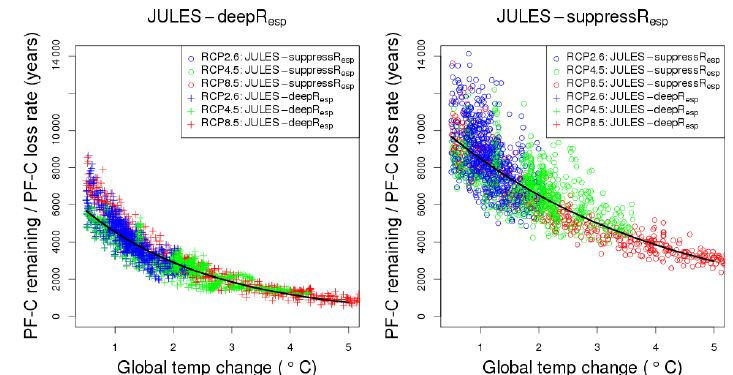
Figure 11. The permafrost carbon remaining in any given year divided by the loss of permafrost carbon in that year (FCRt) as a function of global mean temperature change ( (cid:49)T ). The black line is the exponential fit to the model points.